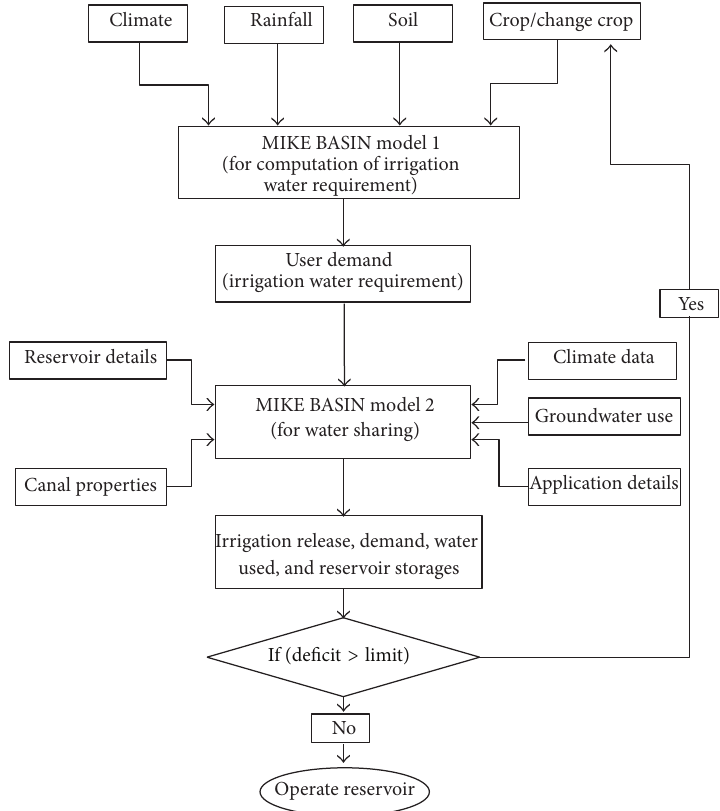
Figure 2: Flow chart for development of DSS for opeartion of the Rangawan